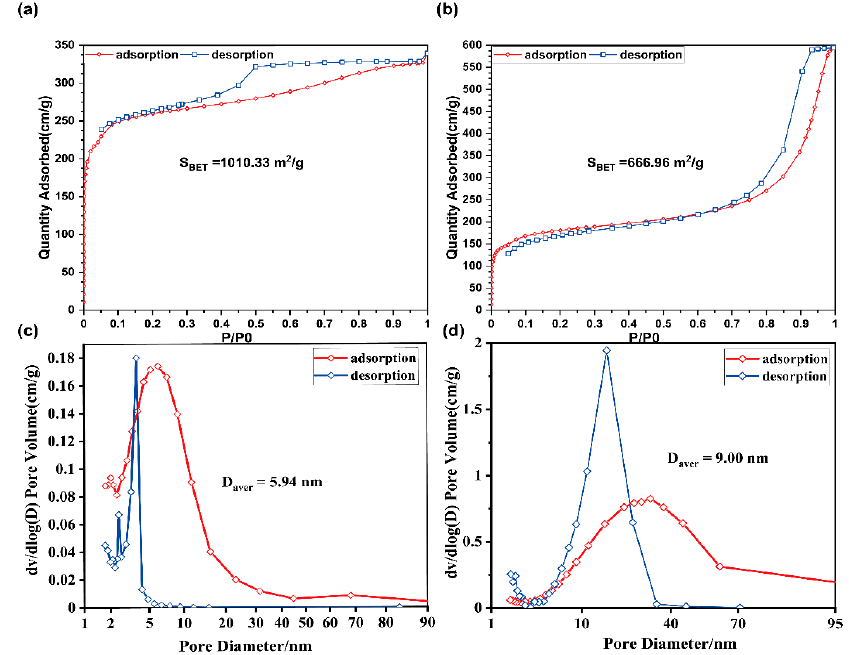
Figure 7. BET analysis and pore size of the as-prepared materials: the adsorption–desorption curve and pore size of ( a / c ) ZIF-8 and ( b / d ) Ag@ZIF-8 nanomaterials.